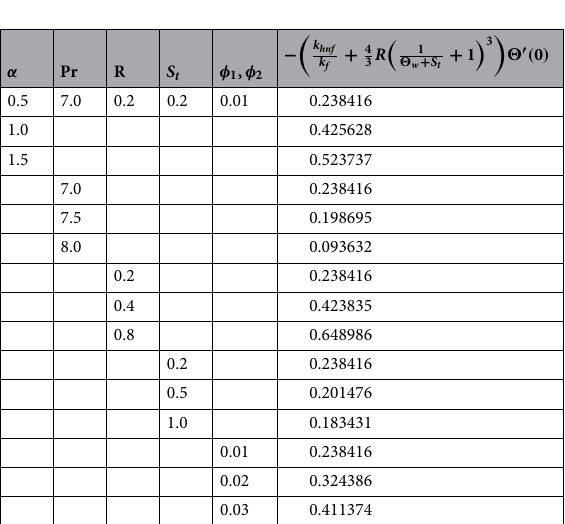
[ Re r ] 1 2 Nu x = 2